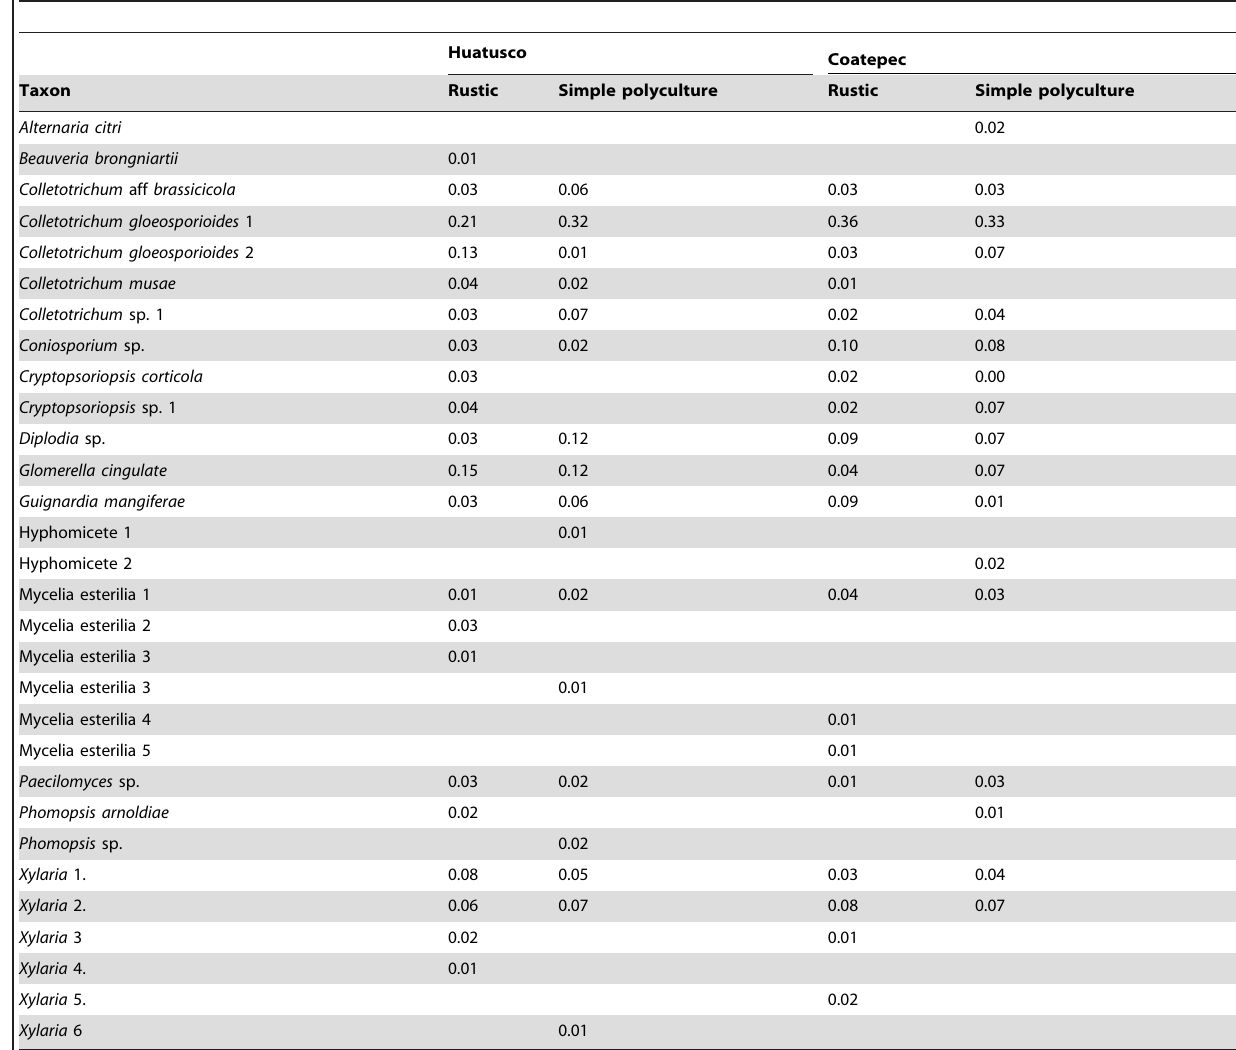
Table 2. Morphospecies of endophytic fungi from the four coffee plantations and their frequencies.